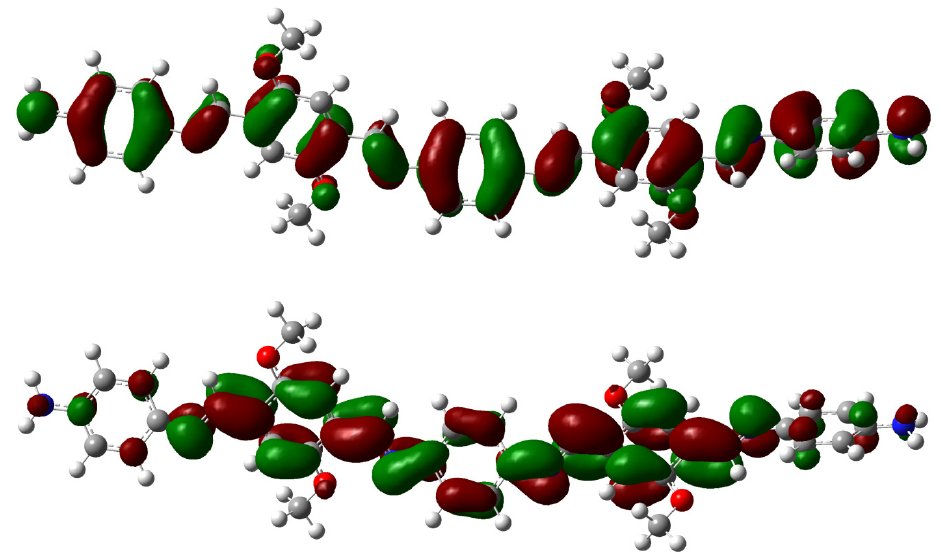
Figure 11. Molecular orbitals: HOMO (top) and LUMO (bottom) of OIC1MS calculated at the M062X/6-31G* level of theory. The aliphatic chains were removed, and the geometries were optimized as described in the